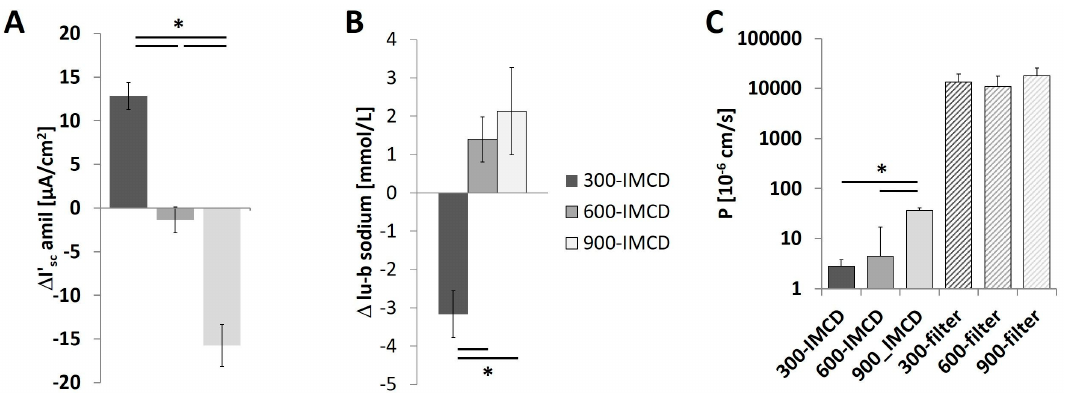
Figure 7. Transepithelial transport parameters of 300-IMCD, 600-IMCD, and 900-IMCD after five days’ cultivation. ( A ) Amiloride-sensitive equivalent short-circuit current ∆ I’ sc . ( B ) Na + concentration difference between luminal and basolateral cultivation medium, ( C ) summarized 40 kD FITC–dextran permeability. Data are means ± SEM, IMCD filters: n = 10,11,11; empty filters: n = 3, 3, 3; * p < 0.05.